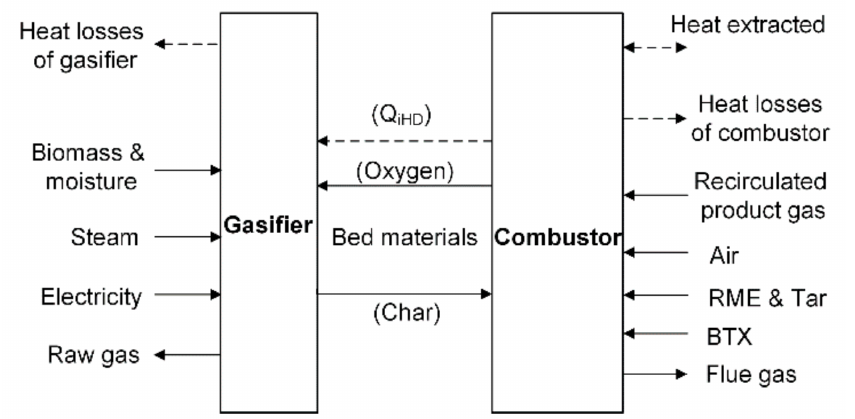
Figure 3. Mass and energy streams and the control volumes of dual fluidized bed. (RME: rapeseed oil methyl; BTX: benzene, toluene and xylene; Q iHD : internal heat demand of